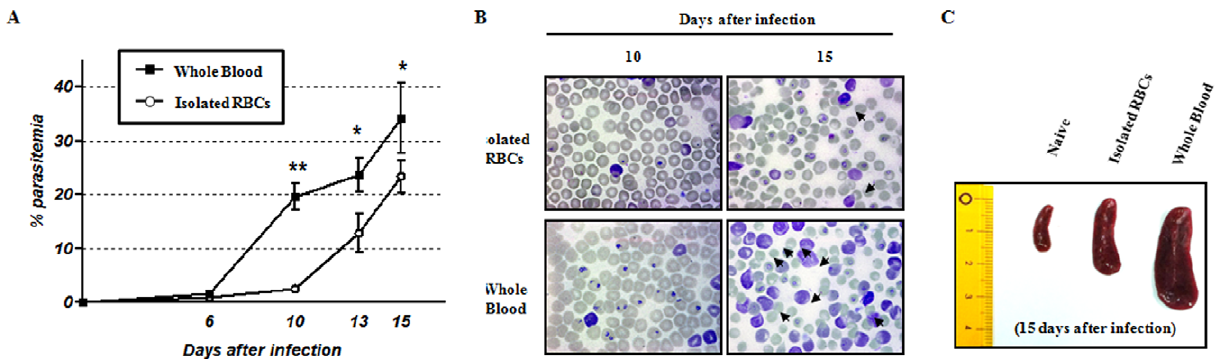
Figure 2. Comparison of susceptibility to B.microti infection between inoculation with purified RBCs alone versus whole blood. RBCs were separated from whole blood of B. microti -infected mice by Percoll gradient centrifugation, and then mice were inoculated with either whole blood or RBCs alone. (A) Development of parasitemia in mice infected with either purified RBCs alone or whole blood. The results are expressed as the mean percent parasitemia 6 the standard deviation of five mice on the indicated day after infection. Asterisks indicate statistically significant differences between mice infected with whole blood versus isolated RBCs alone. * P , 0.05 and ** P , 0.01 (B) Identification of damaged or dead RBCs using Wright-Giemsa-stained blood smears. Arrows indicate damaged or dead erythrocytes caused by B. microti infection. (C) Comparison of spleen enlargement. All results represent $ two independent experiments with five mice in each group.